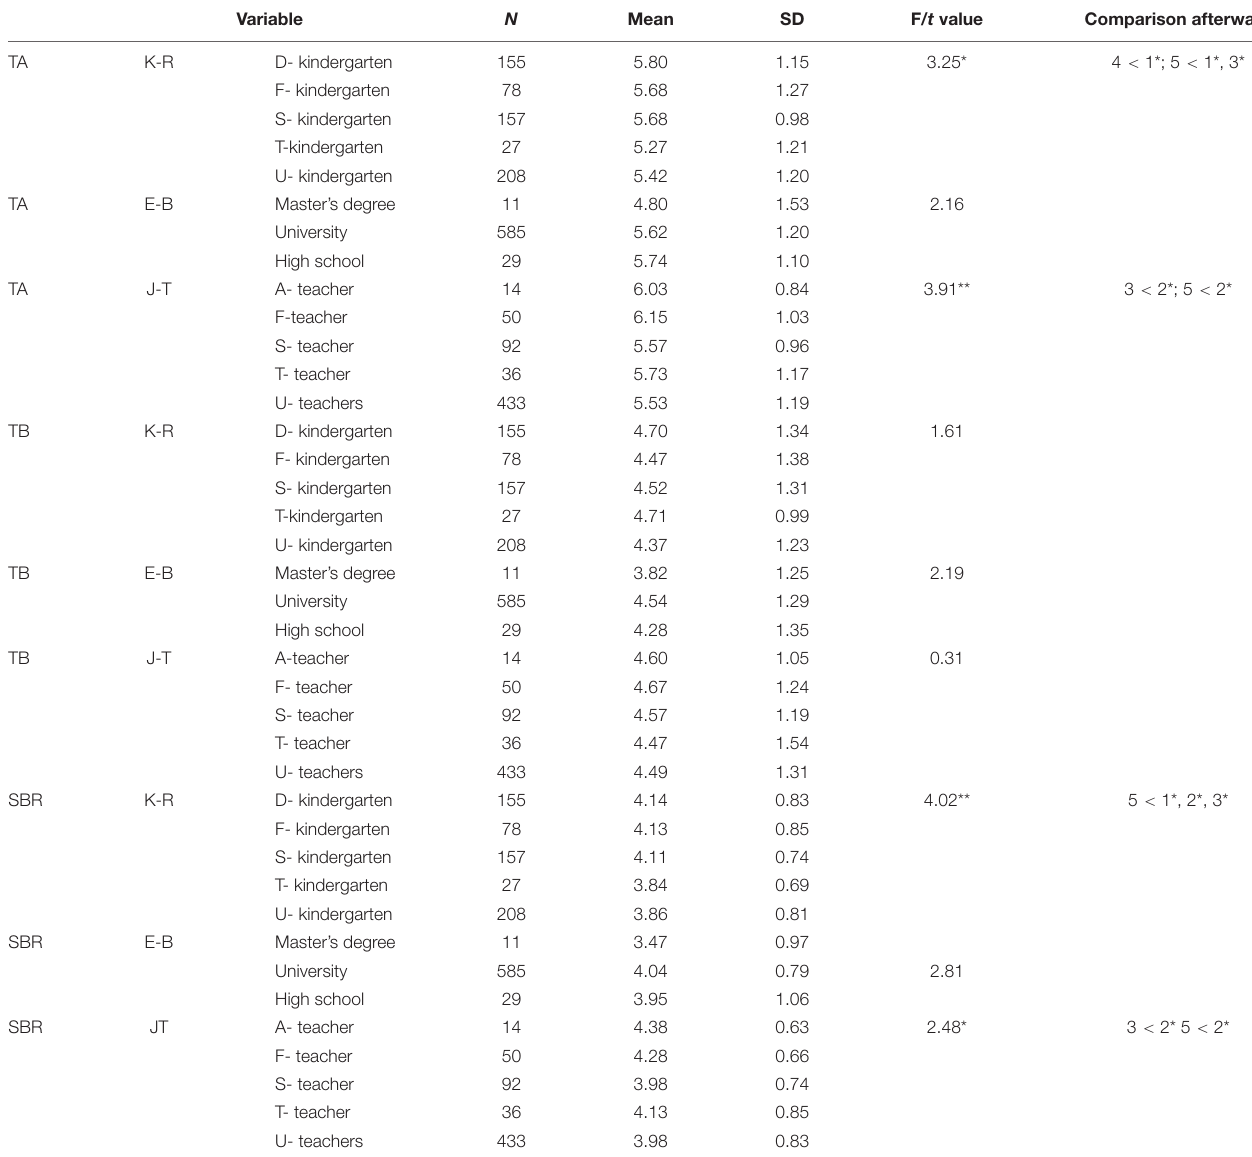
TABLE 1 | The difference test of SBR and teaching